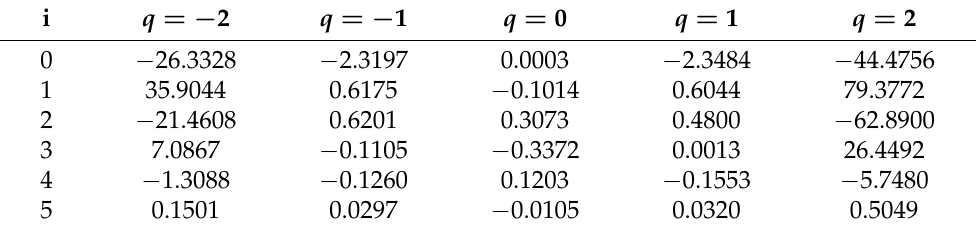
Table A1. Fit coefficients up to ± 2 elementary charges for Equation